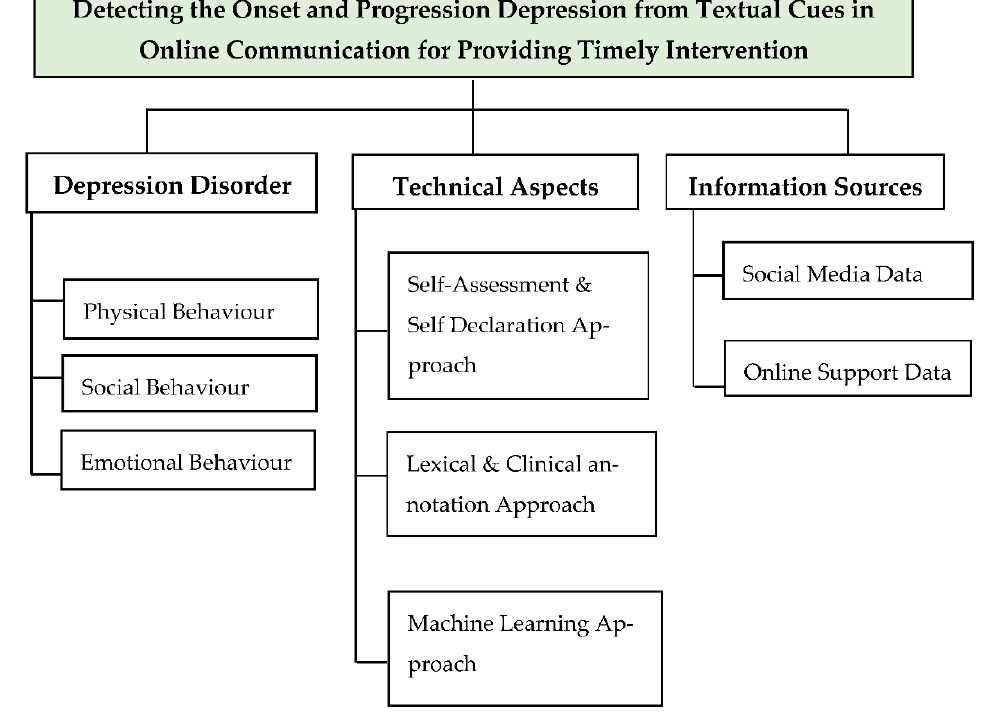
Figure 2. Distribution of Selected Domain areas.